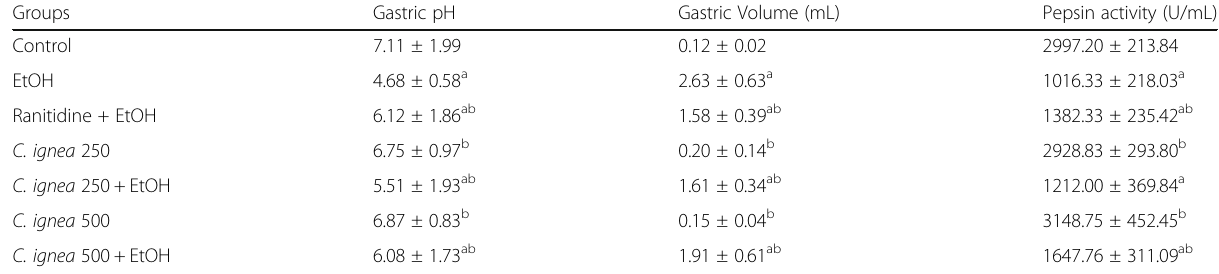
Table 3 Effect of C. ignea aerial parts extract on pH, volume and pepsin activity of gastric juice in various experimental groups Groups